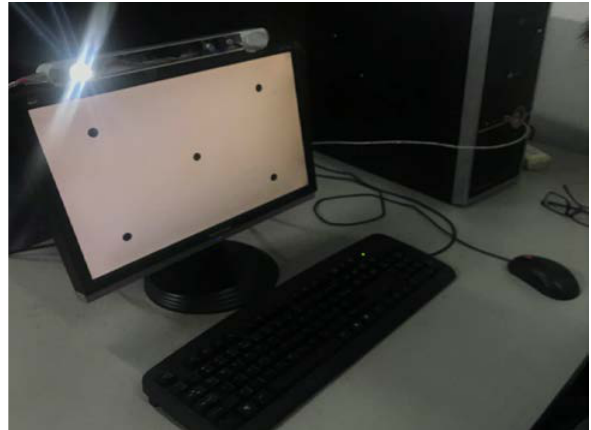
Figure 12. Construction of gaze tracking system.